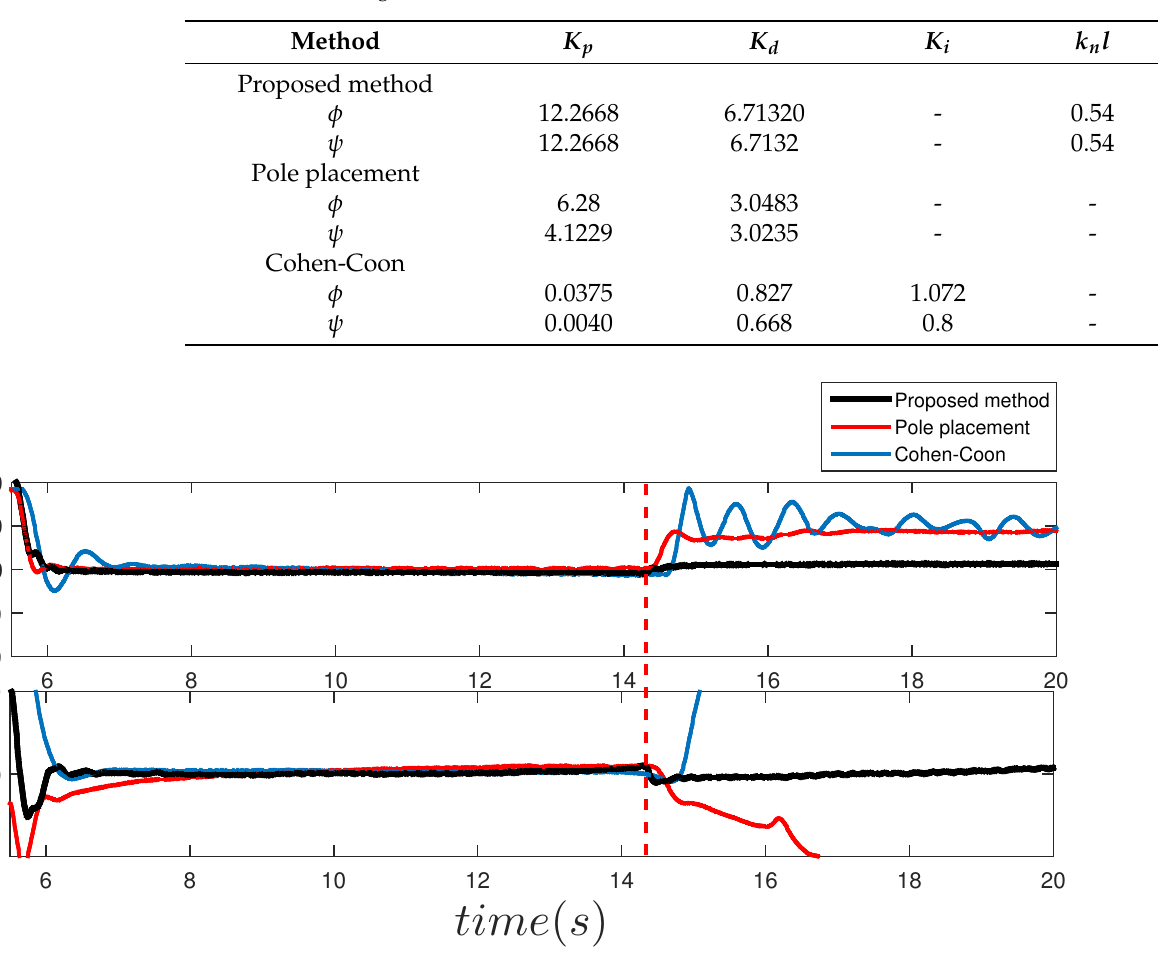
Table 2. Controller gain values.